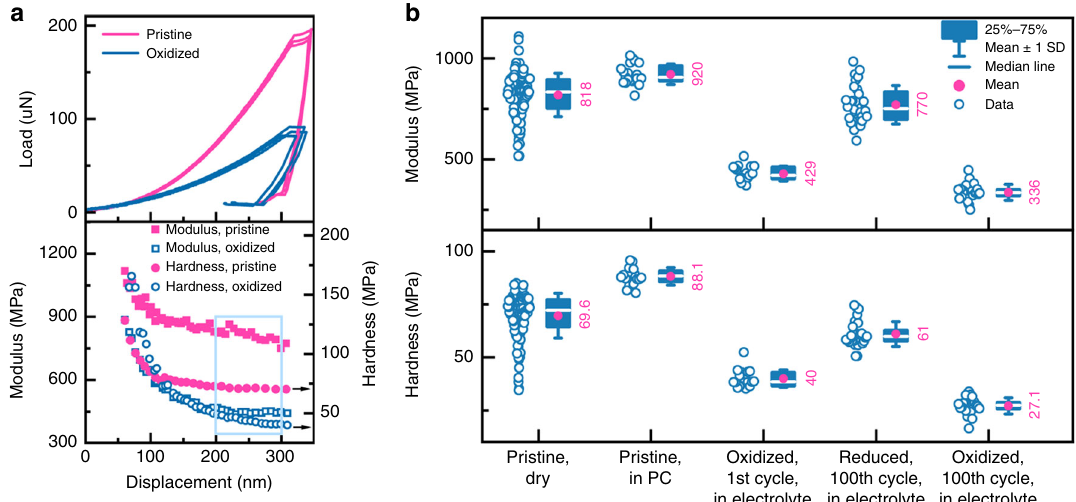
Fig. 3 Mechanical properties of PProDOT fi lm. a Upper panel: the load-displacement curves of indentation on the pristine and oxidized PProDOT fi lms. Lower panel: Modulus and hardness of the pristine and oxidized PProDOT as a function of the indentation depth. b Modulus (upper panel) and hardness (lower panel) of PProDOT in the pristine and dry state, the pristine state in PC, the oxidized state in electrolyte after the 1 st cycle, the reduced state in electrolyte after 100 cycles, and the oxidized state in electrolyte after 100